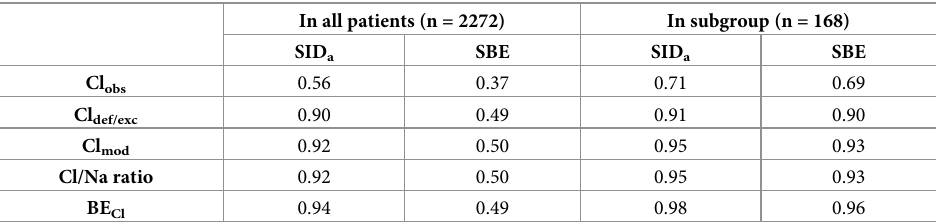
BE Cl , base excess chloride; Cl def/exc , chloride deficiency/excess; Cl mod , chloride modification; Cl obs , observed serum chloride level; SBE, standard base excess; SID a , apparent strong ion